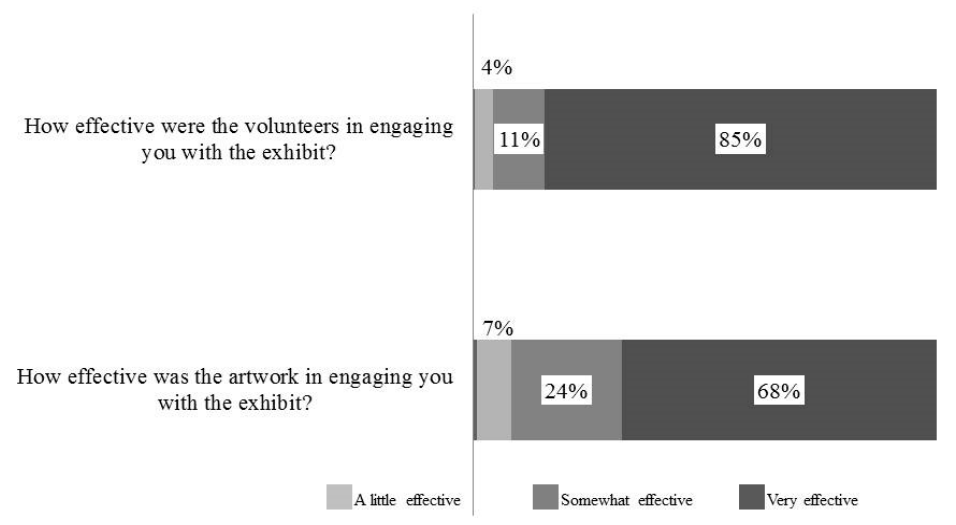
Figure 6. The majority of participants reported that the volunteers (top bar) and the artwork (bottom bar) were “very effective” in engaging them with the exhibits. Data included are from BP, UNSM 2014, DMNS, and TZ.